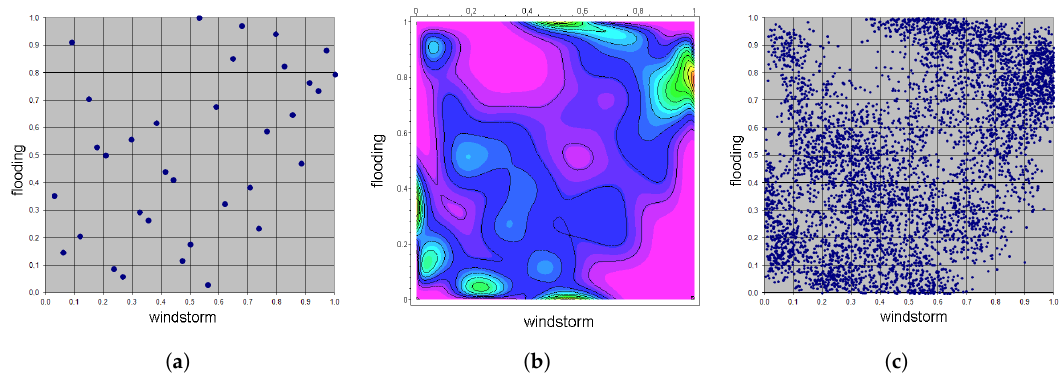
Figure 5. Plots for the empirical Bernstein copula in Example 3. ( a ) Support points of scaled skeleton. ( b ) Empirical Bernstein copula density contour plot. ( c ) Simulation of 5000 empirical Bernstein copula pairs.